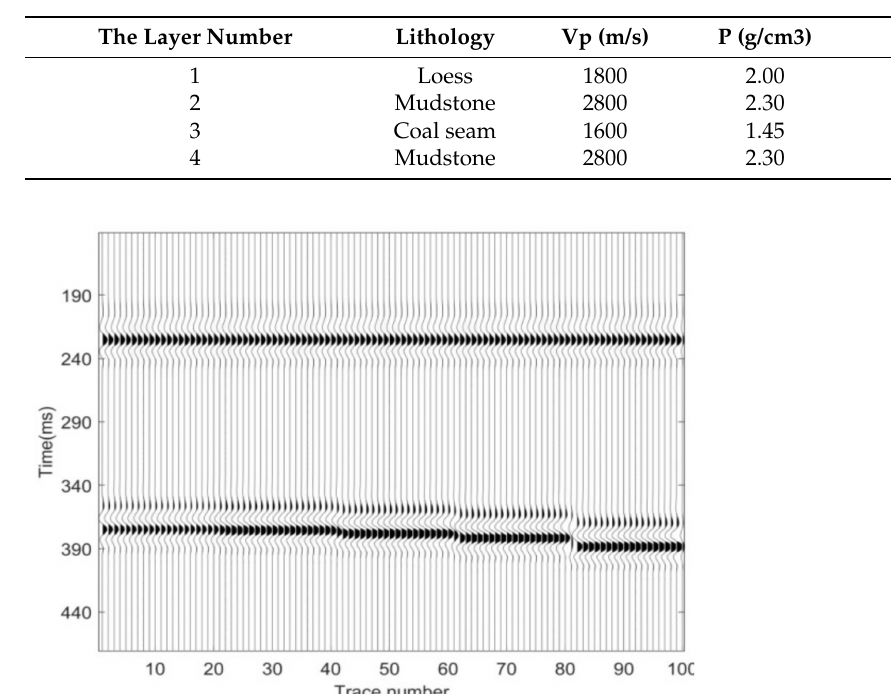
Table 1. Geological model parameters.